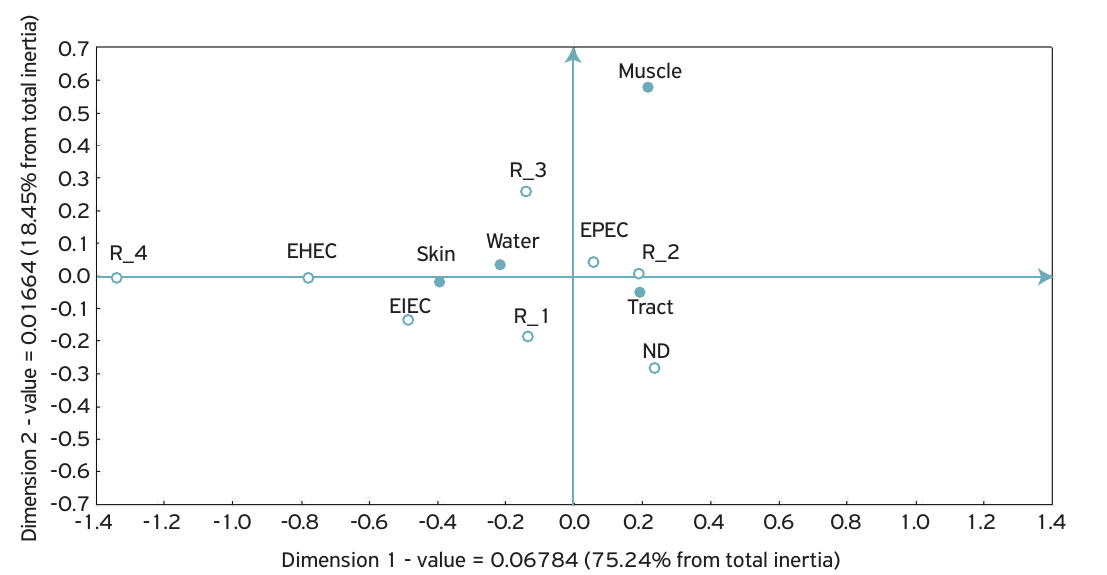
Figure 1. Percentage map derived from the correspondence